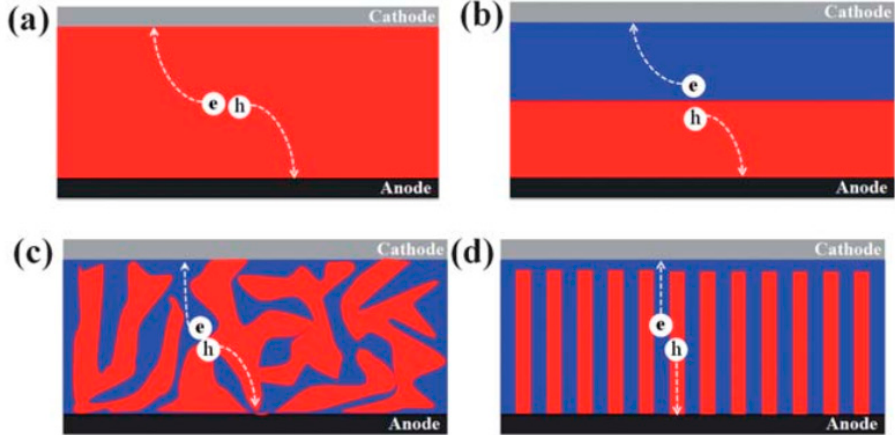
Figure 13. Schematic of various types of device architectures of solar cells. Red domains correspond to electron donor phases, while blue domains correspond to electron acceptor phases ( a ) Single-layer device, sandwiched between electrodes with different work functions; ( b ) bilayer device, with increased efficiency due to exciton dissociation occurring at the interface between phases; ( c ) bulk heterojunction device, where domain size is close to the exciton diffusion length of around 10 nm; ( d ) A proposed ideal film morphology, and ordered bulk heterojunction device where electrons and holes always have pathways to their respective electrodes. Reproduced from [72] with permission of the Royal Society of